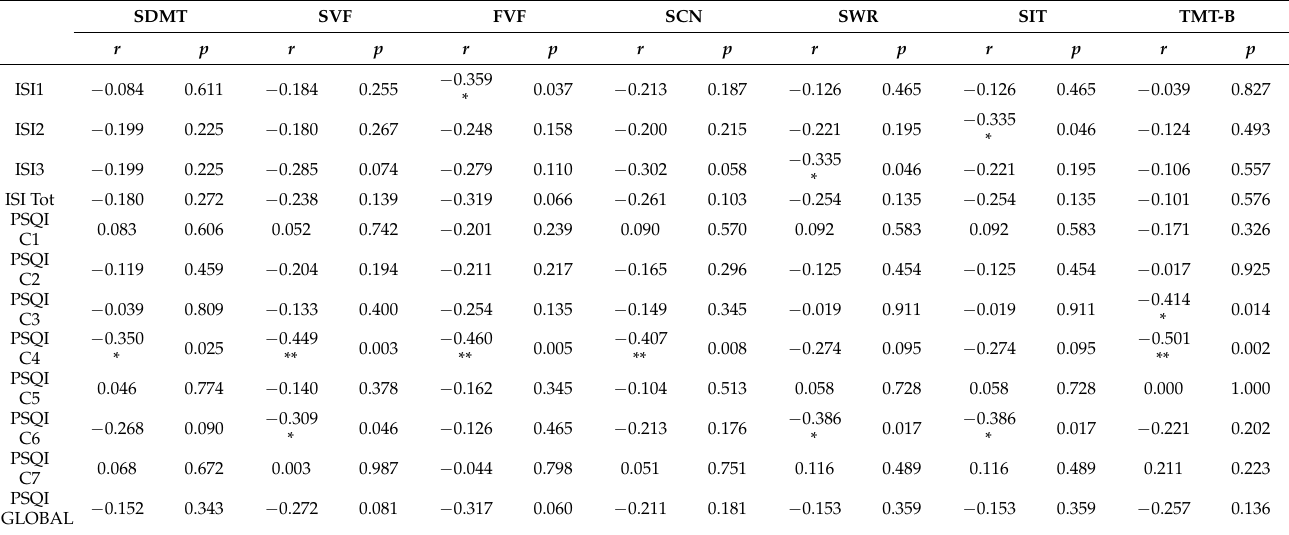
Table 3. Pearson’s correlations (and related level of significance) between cognitive performance and sleep subscales.